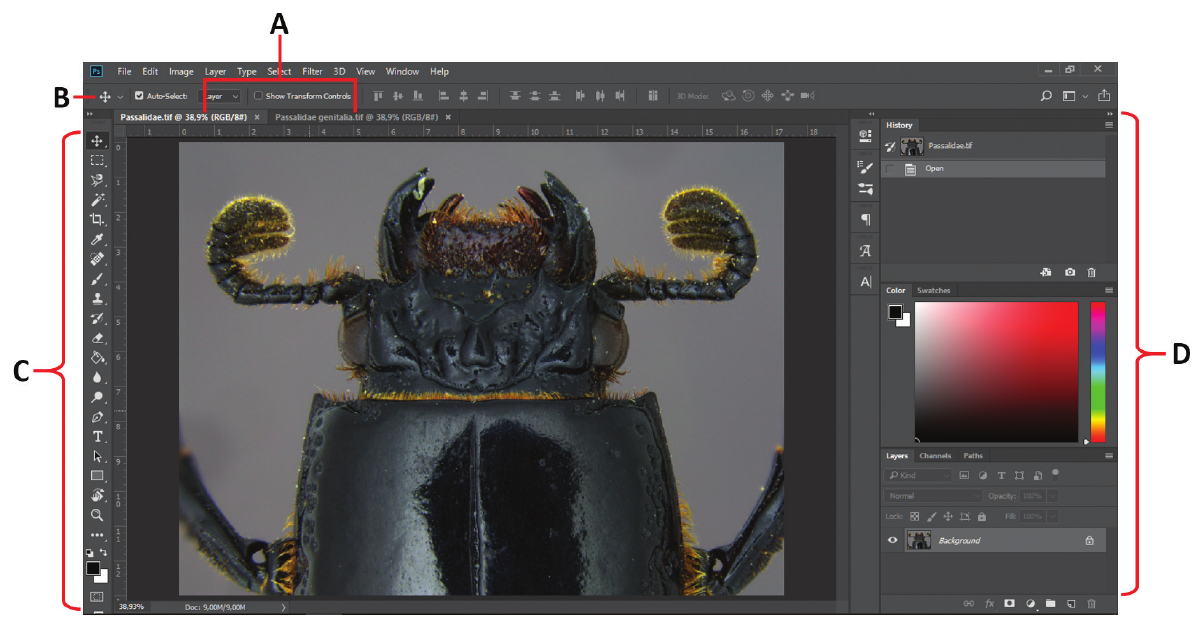
Figure 1. Default Photoshop workspace. A . Tabbed document windows; B . Control panel; C . Tools panel; D . Panel groups in ver- tical dock.